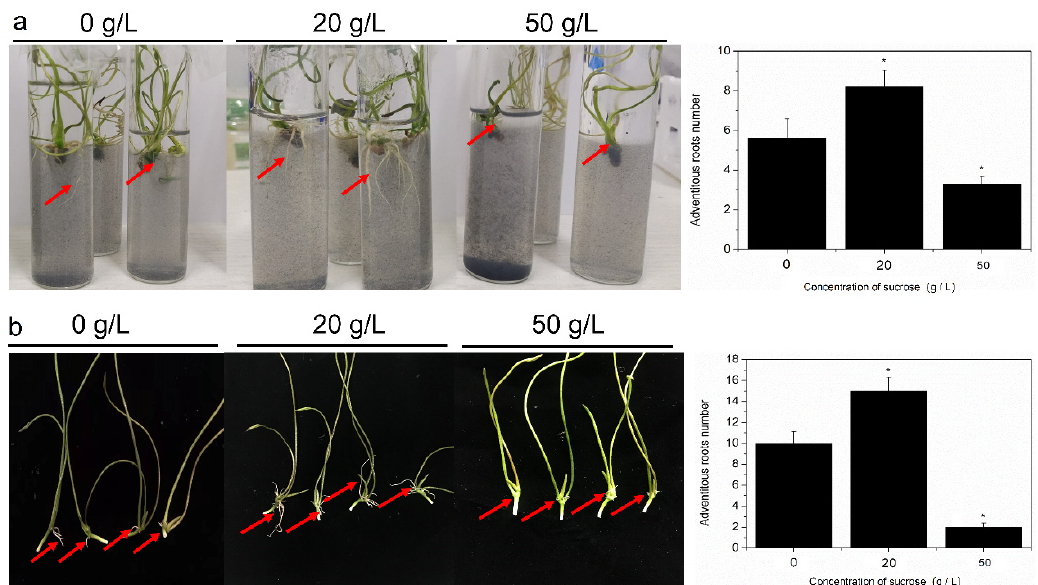
Figure 1. The influence of 20 g/L and 50 g/L sucrose on ARs formation in lotus seedlings. ( a ) AR formation in the water; ( b ) AR development in the MS medium (the data of ( b ) were referred by Cheng et al. 2020 [19]). (Red arrow represents point of the growth of adventitious root; “*” represents significant difference, p < 0.05.)